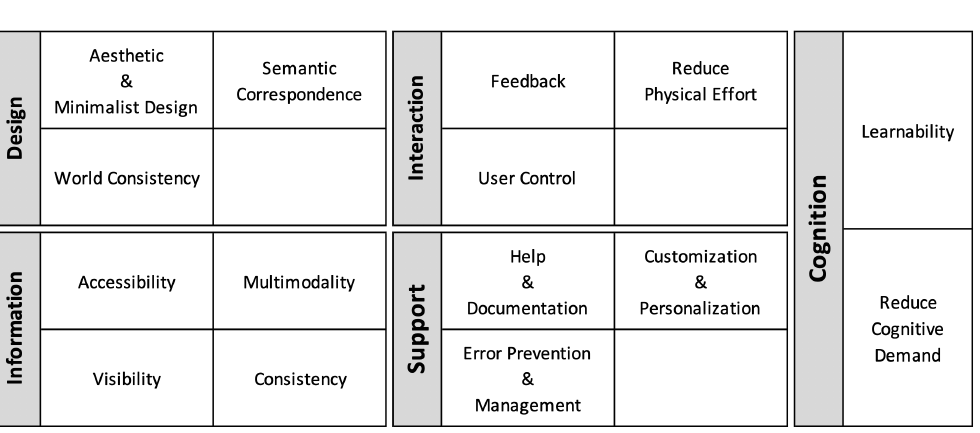
Figure 2. Final pattern